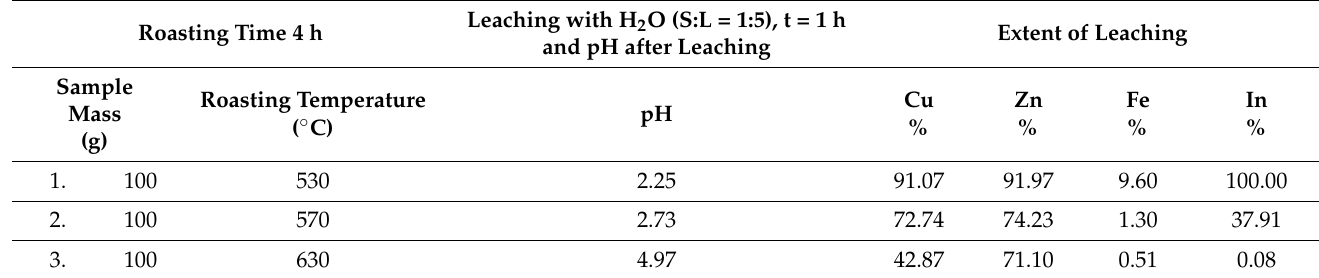
Table 3. Conditions for the jarosite roasting and leaching